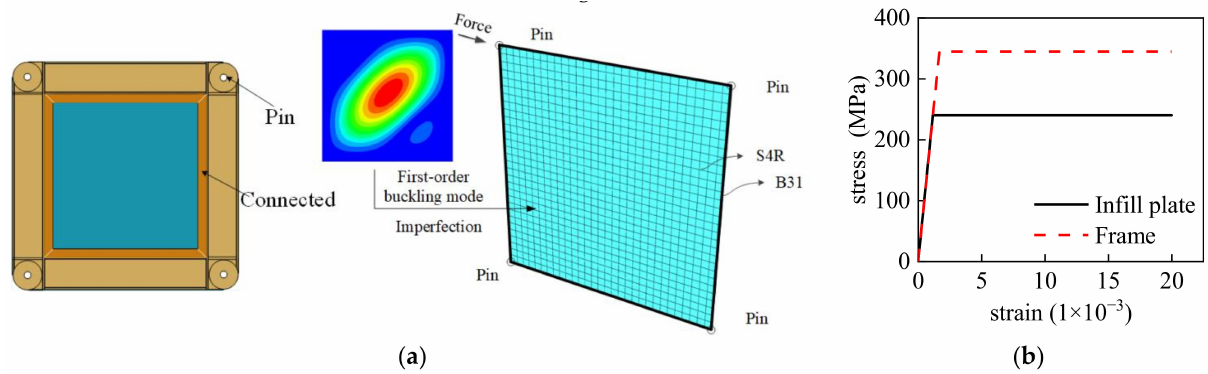
Figure 5. Finite element model of SPSW: ( a ) FE model of steel plate shear wall; ( b ) stress–strain relationship.